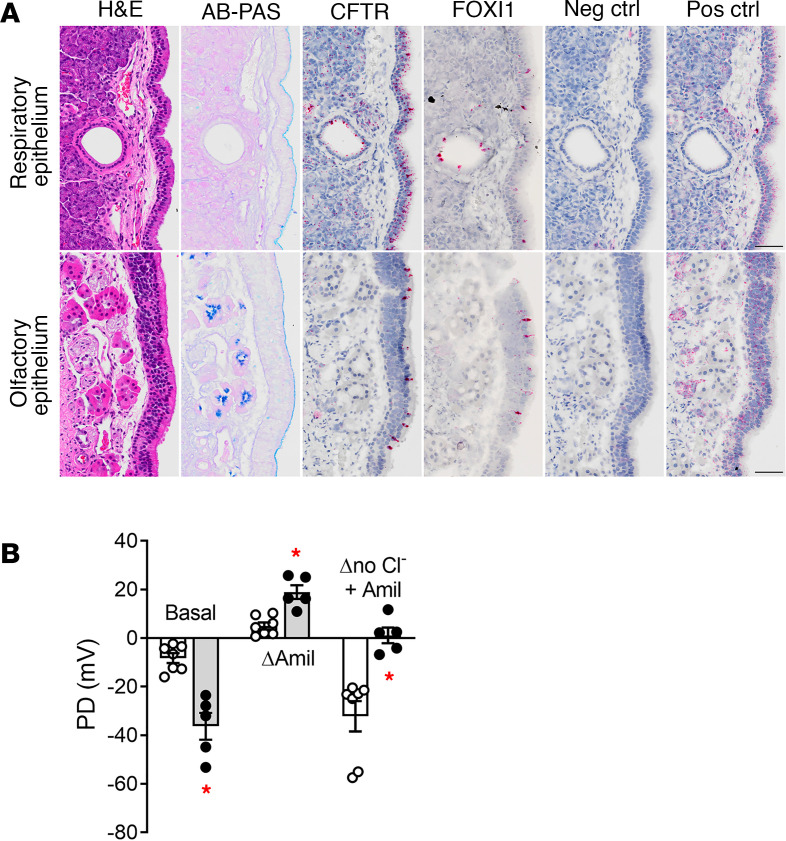
Characterization of CFTR expression and function in the rabbit nasal cavity.(A) Representative micrographs of respiratory and olfactory epithelium from WT rabbits (approximately 3-month-old), stained with H&E and AB-PAS, and probed for CFTR, FOXI1, negative control (bacterial gene 4-hydroxy-tetrahydrodipicolinate reductase), and positive control (rabbit gene peptidylprolyl isomerase) mRNA by RNAscope (red chromogen). Scale bar: 50μm. Representative micrographs from n = 2 rabbits. (B) In vivo measurements of transepithelial nasal potential difference (NPD) in WT (white bar, white dots) and CF (gray bar, black dots) rabbits. Basal, amiloride sensitive, and Cl– free with amiloride (no Cl– + amil) PD responses measured in the left nostril are shown. Equivalent measurements were obtained for the right nostril. n = 7 WT and 5 CF rabbits. *P < 0.05 versus WT. Unpaired, 2-tailed t test with Welch’s correction for unequal variance.